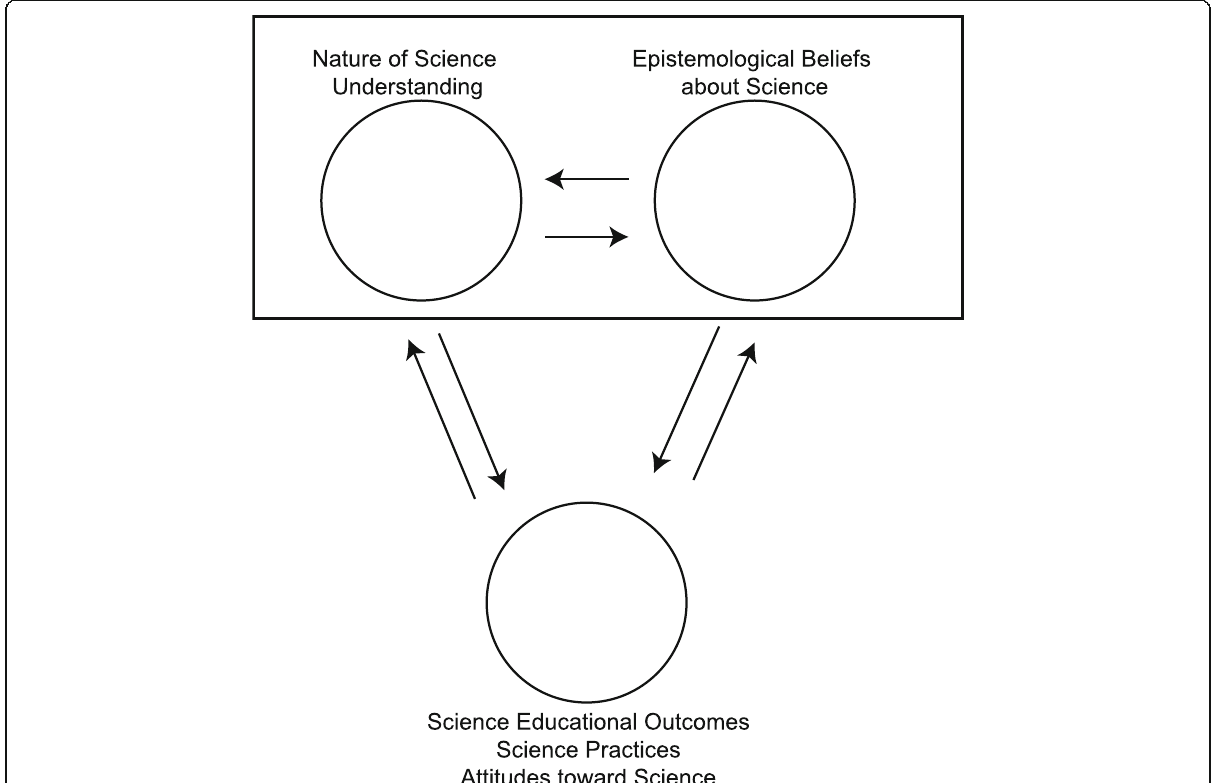
Fig. 1 Our conceptualization of the relationship between NOS understanding, epistemological beliefs, and outcomes. We propose that what individuals know and believe influence one another, and that these can then influence practices. An individual ’ s experience in a classroom